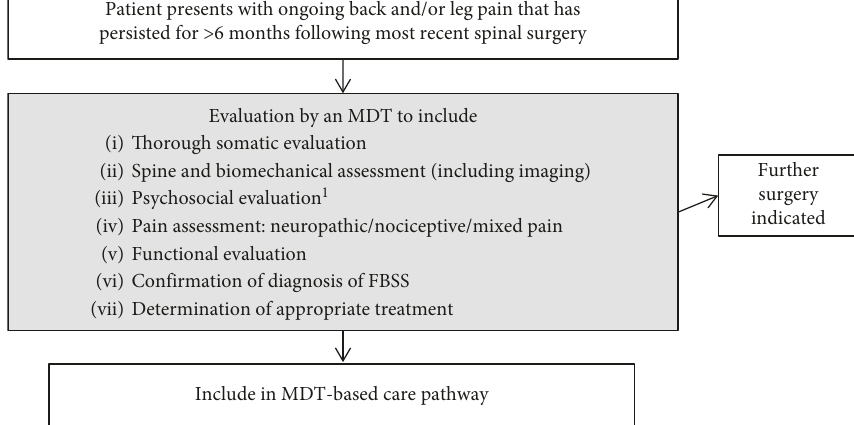
Figure 2: The initial stage of the proposed standardized multidisciplinary team failed back surgery syndrome care pathway, as recom- mended by the Chronic Back and Leg Pain Network. Clinical evaluation and confirmation of diagnosis. FBSS, failed back surgery syndrome; MDT, multidisciplinary team. 1 Best practice is for the psychosocial evaluation to be performed by a psychologist or psychiatrist with specific experience in the field of pain. Assessment should include the relevant tests and questionnaires that are able to identify patients with major psychological or psychiatric contraindications (Table